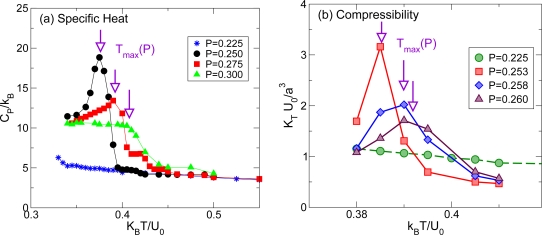
(Color online) Response functions for the Jagla ramp model as function of temperature for different values of P > Pc (Figure 2, path α) and P < Pc (Figure 2, path β). (a) Constant pressure specific heat CP and (b) isothermal compressibility KT. Both CP and KT have maxima, as is known to occur experimentally for the liquid-gas critical point [79] and for the LLCP [60]. For large P the peaks become less pronounced and shift to higher temperature as the Widom line has positive slope. Adapted from Reference [34].